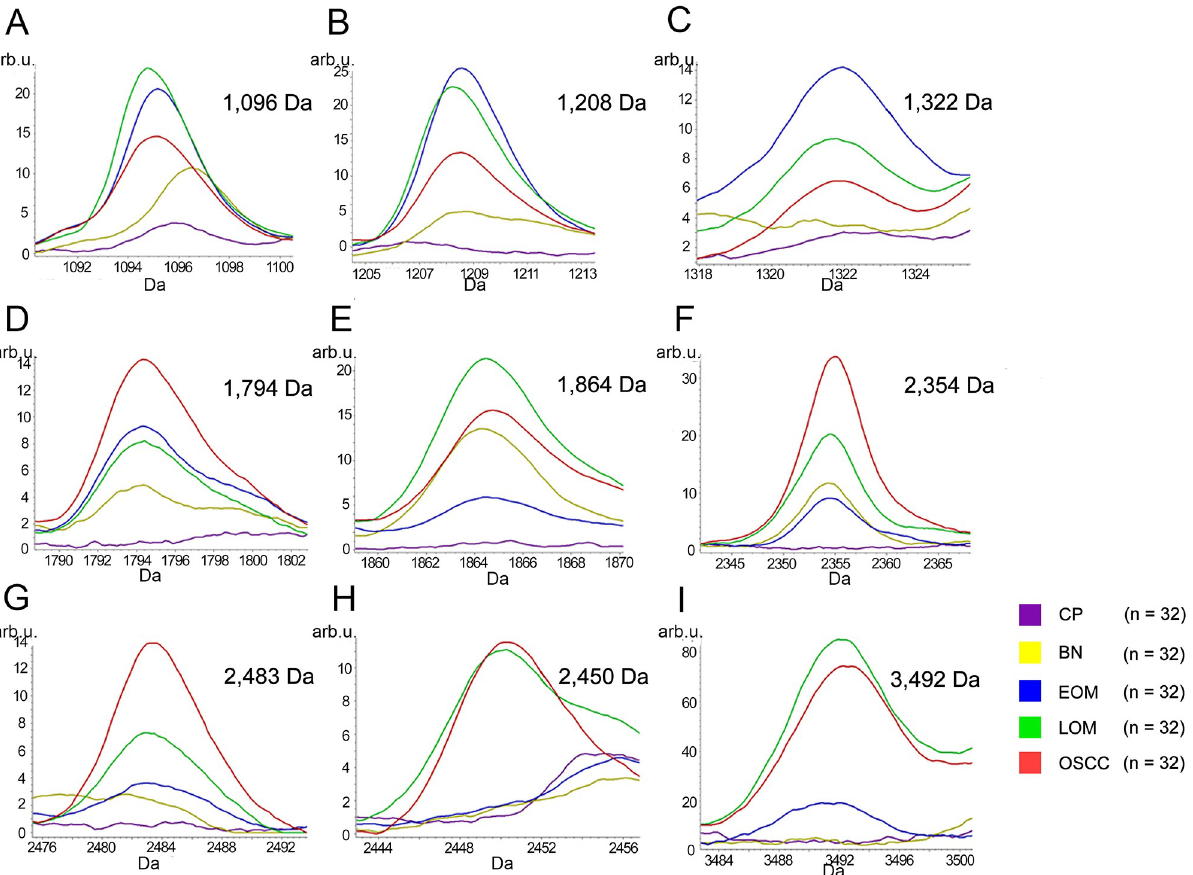
Fig 3. MALDI-TOF intensity profiles of salivary proteins from benign tumors (BN), early-stage oral melanoma (EOM), late-stage OM (LOM) and oral squamous cell carcinoma (OSCC). Percentages of interpretable mass signals are shown: SENP7 or KAT2B at 1096 Da (A); PPRC1 or RMND1 at 1208 Da (B); DTX3L at 1322 Da (C); ZNF699 at 1794 Da (D); MAP3K15 or ATP6V1E2 at 1864 Da (E); PLCL2 at 2354 Da (F); COL12A1 at 2483 Da (G); TNRC18 at 2450 Da (H); TLR4 at 3492 Da (I). arb. u., arbitrary